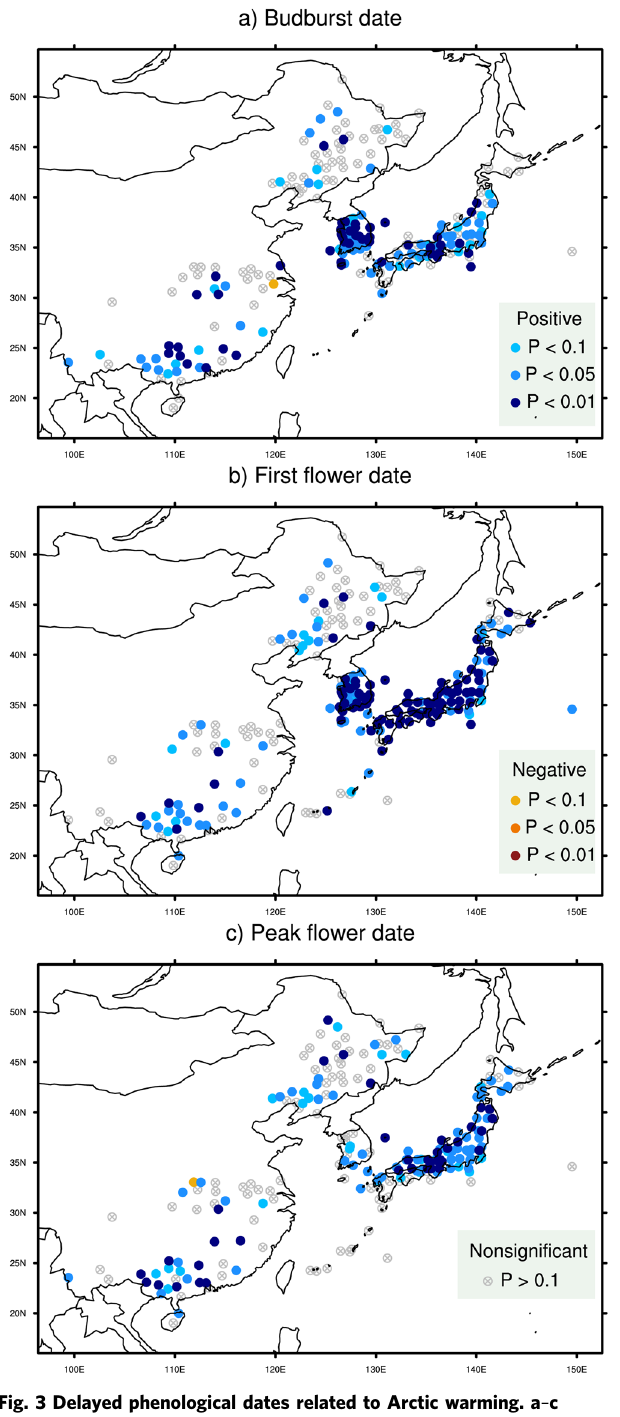
Fig. 3 Delayed phenological dates related to Arctic warming. a – c Statistical con fi dence based on correlation coef fi cient between December – February averaged ART index and in-situ phenological dates observation for budburst ( a ), fi rst fl ower ( b ) and peak fl ower dates ( c ) based on Student ’ s t -test. Blue dots indicate delayed phenological dates and red dots earlier phenological dates onto December – February ART